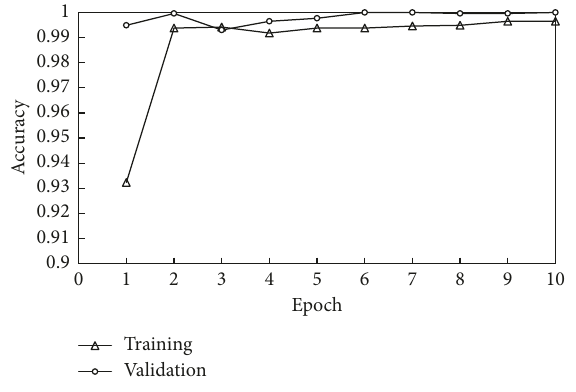
Figure 19: Training time consumptions of different R